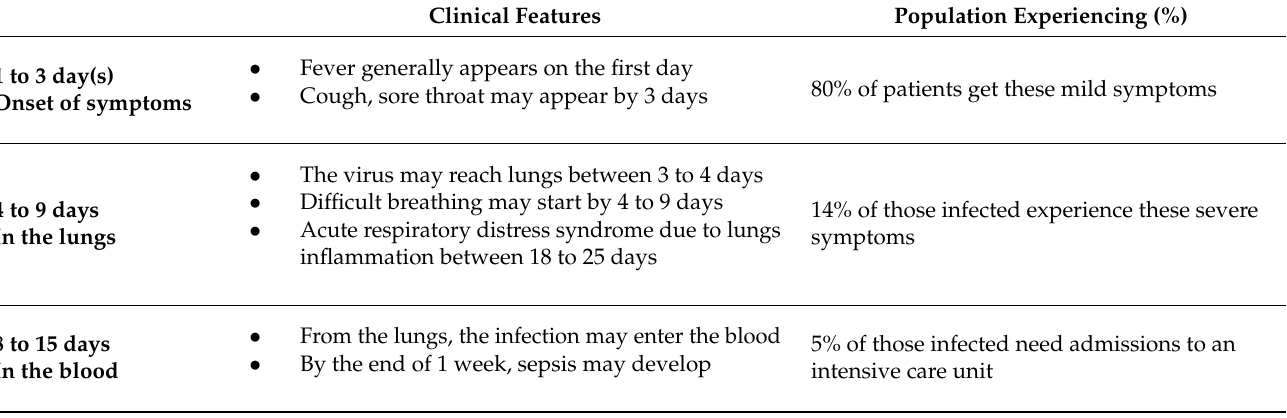
Table 3. Incubation period and onset of symptoms of SARS-CoV-2. Reprinted with permission from Ref. [28]. Copyright 2021 Copyright